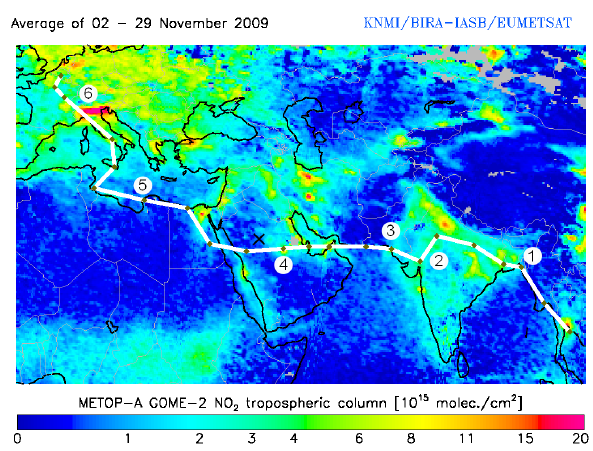
Fig. 3. Flight tracks of the Earth Challenge expedition on a NO 2 GOME-2 map. The numbers correspond to the